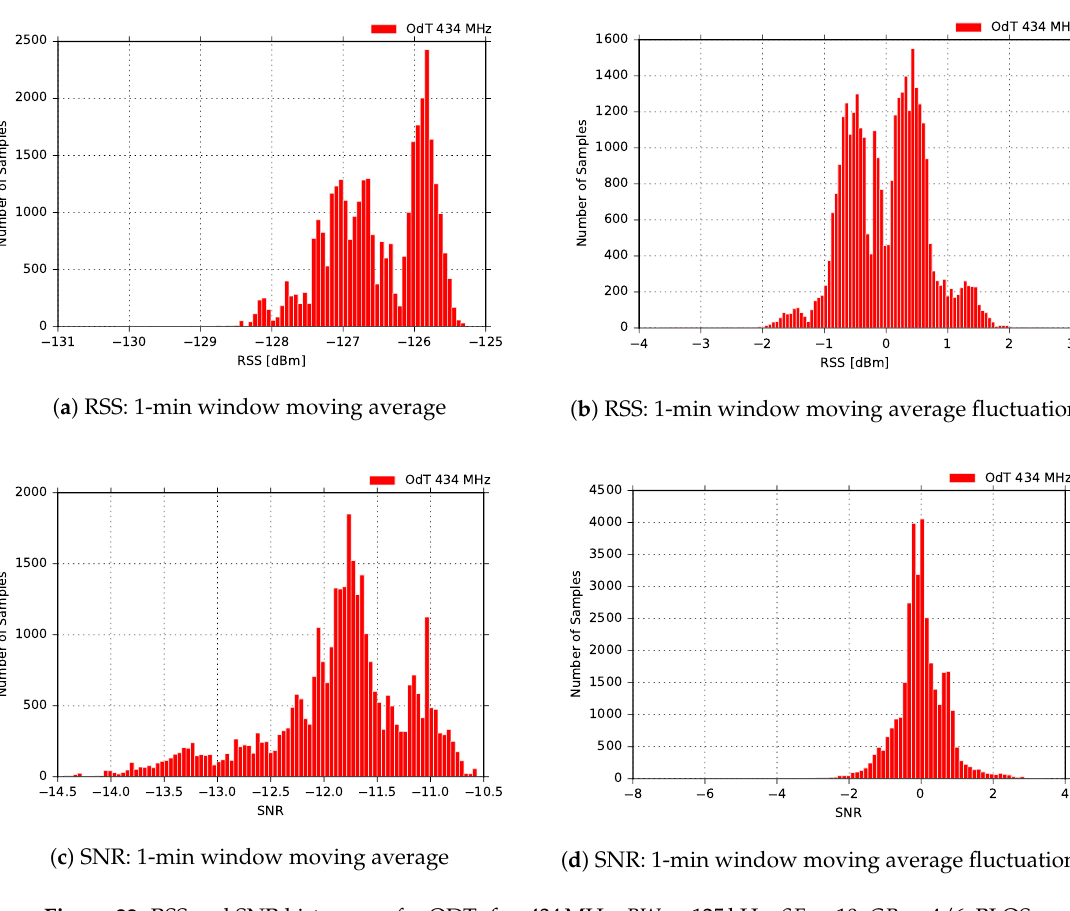
Figure 22. RSS and SNR histograms for ODT: f = 434MHz, BW = 125kHz, SF = 10, CR = 4/6,